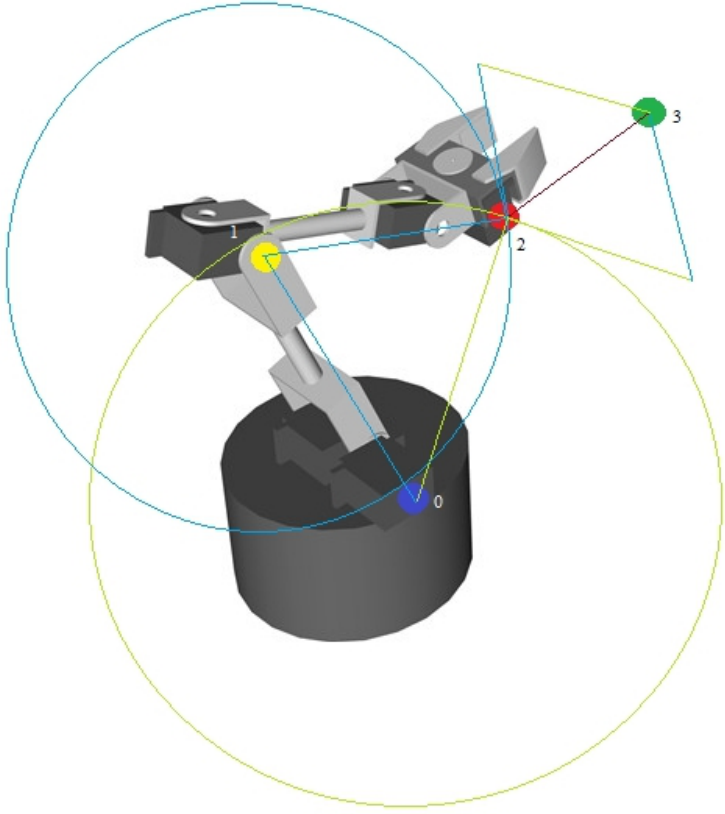
Figure 1. Auxiliary drawings on the 3D model of the robotic